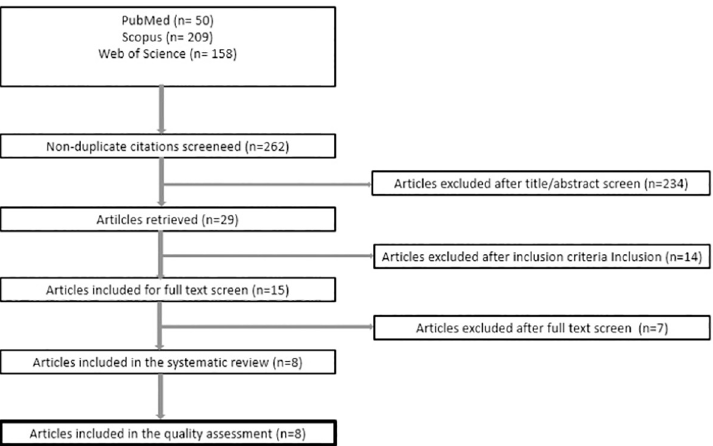
Fig 1. Preferred Reporting Items for Systematic Reviews and Meta-Analyses (PRISMA) fluxogram of study selection.